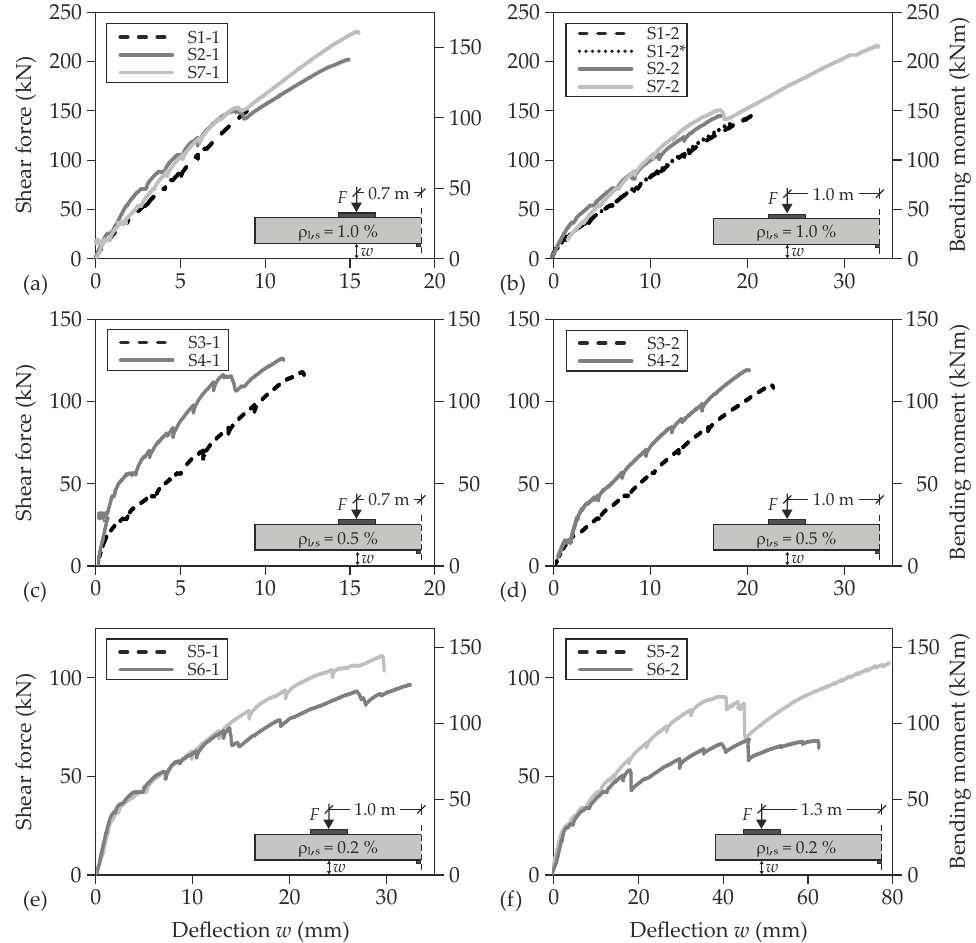
Figure 13. Load deflection curves of large-scale tests on slab segments with static loading ( a – f ) separated by combination of flexural reinforcement and load